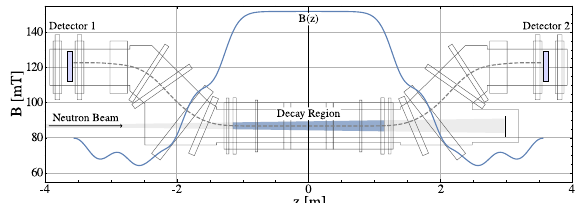
Figure 1. Electrons originating from the central region ( | z | < 1 m ) of P ERKEO III follow the magnetic field lines (dashed) and end up in one of the detectors located at | z | ≈ 3 . 6 m . Due to the inverse magnetic mirror effect, the maximum polar angle of the electron momentum is ≈ 47 ◦ in the detector region.